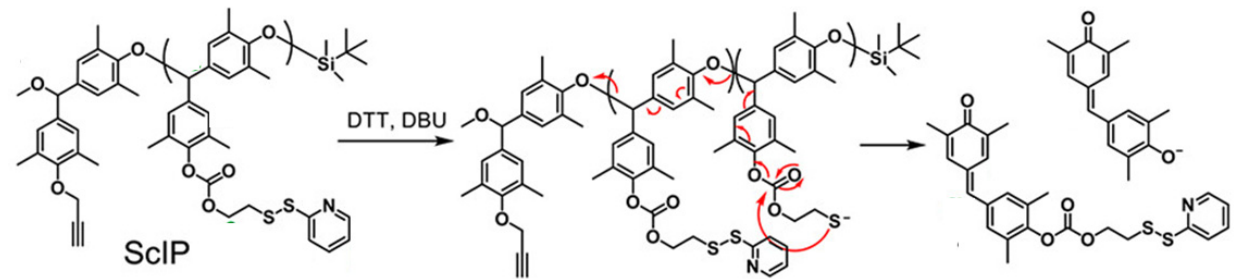
Figure 25. Proposed mechanism for the unidirectional self-immolative depolymerization of the ScIP after exposure to DTT and DBU. Data from electrospray ionization-mass spectrometry were able to identify the two molecules on the far right as the predominant products Reprinted with permission from [89]. Copyright (2019) American Chemical Society.